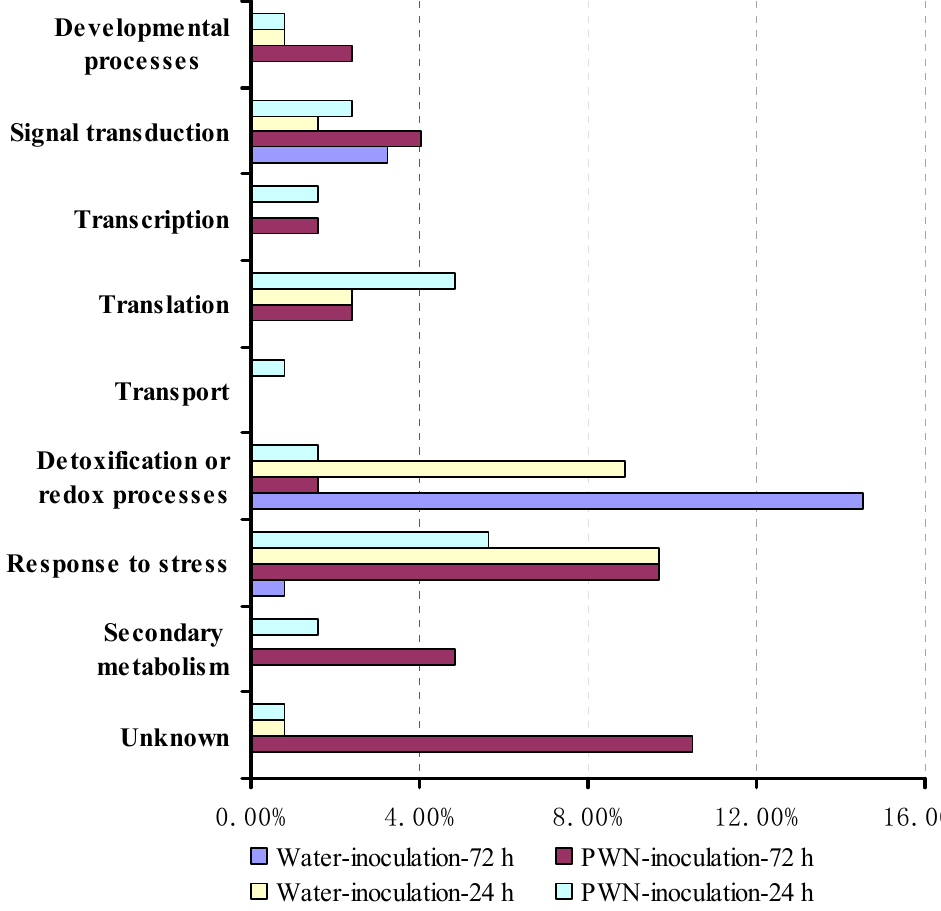
Figure 1. Functional classification of the ESTs from the SSH libraries. For library stems that were sampled at 24 h and 72 h after inoculation were used as the tester set, and the mRNAs from water-inoculated stems were used as the driver